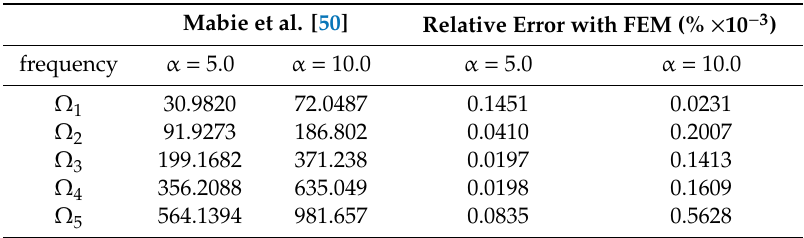
Table 1. Modal analysis for double-tapered cantilever